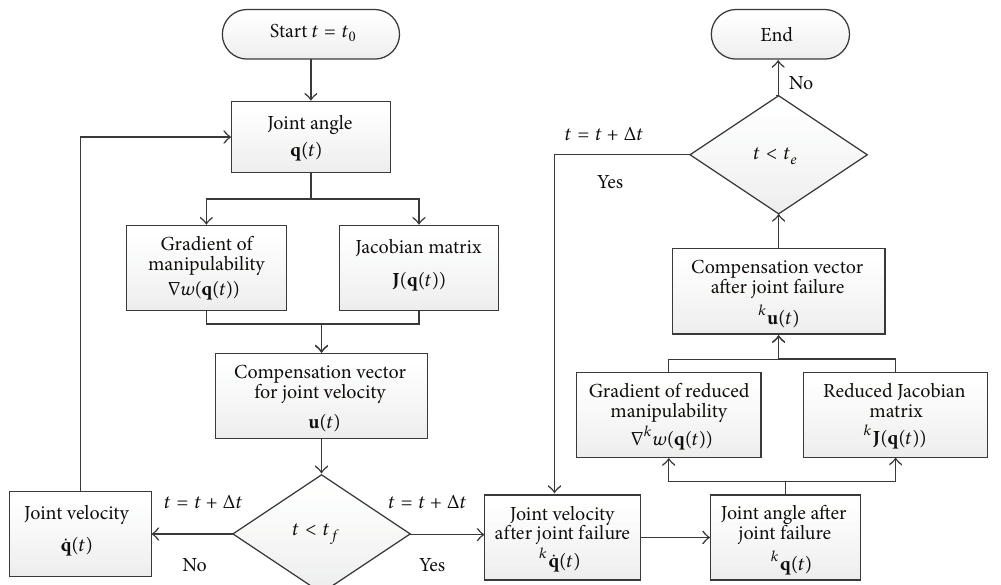
Figure 1: The recurrence relation between u , ̇ q , and q